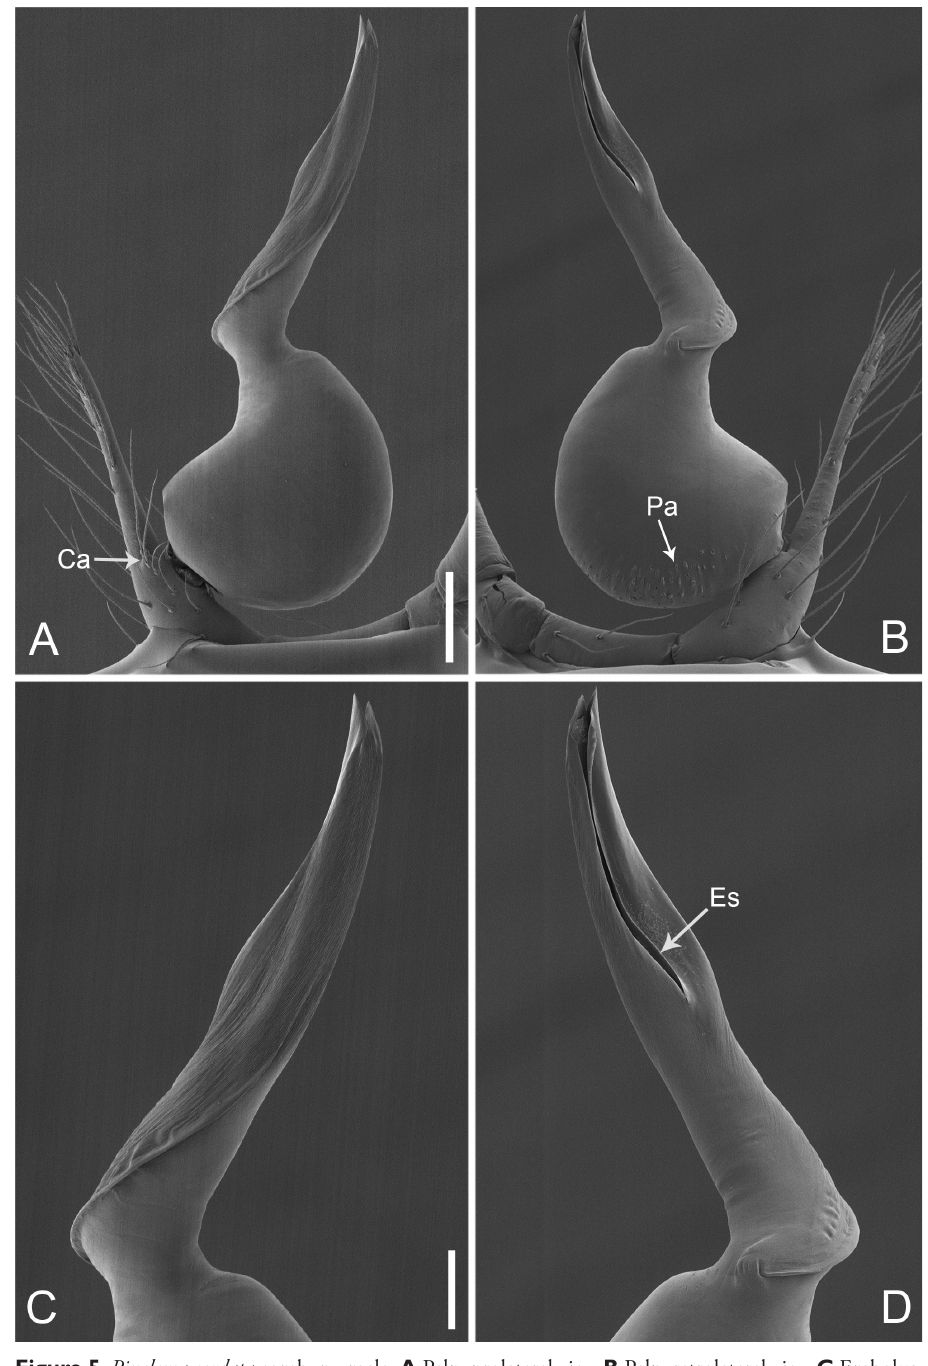
Figure 5. Pinelema cordata comb. n., male. A Palp, prolateral view B Palp, retrolateral view C Embolus, prolateral view D Embolus, retrolateral view. Scale bars: 0.1 mm ( A–B ), 0.05 mm ( C–D